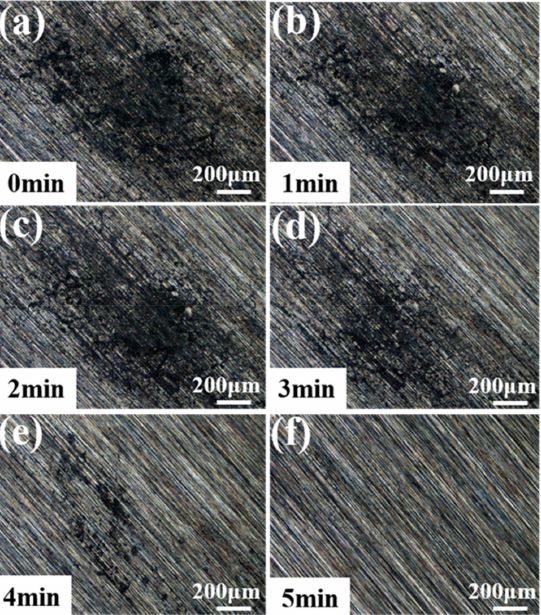
Figure 9. Evolution diagram of the dipped white spots with cleaning time, ( a ) MO image of white- spot-stained silicon wafer before cleaning, ( b ) cleaning for 1 min, ( c ) 2 min, ( d ) 3 min, ( e ) 4 min, ( f ) 5